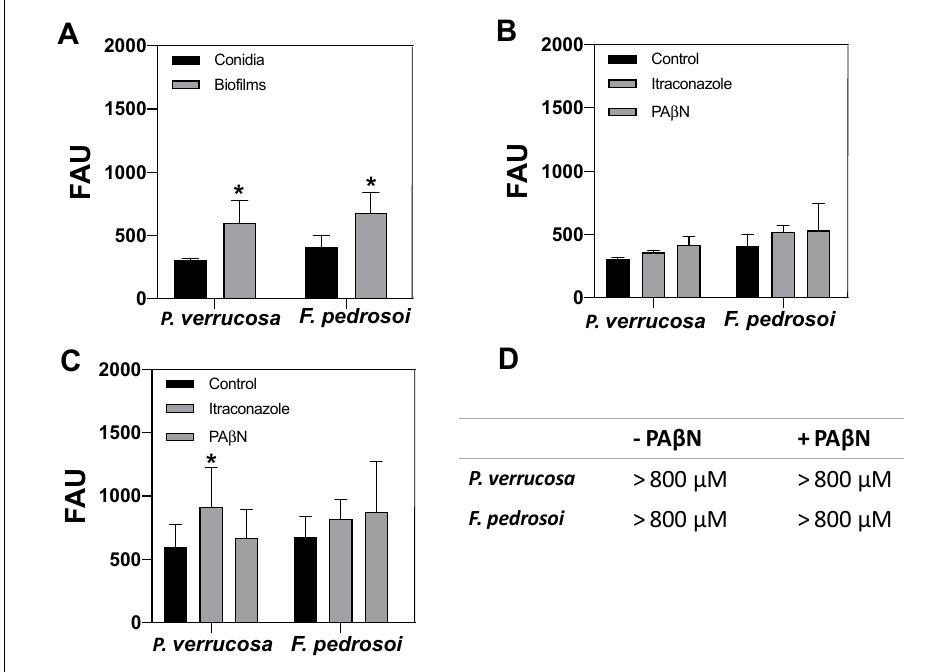
Figure 8. Activity of efflux pumps on conidia and biofilm-forming cells of F. pedrosoi and P. verrucosa . ( A ) Conidial cells and 72 h-old-biofilm (1 × 10 7 /mL, initial inoculums) were first incubated with rhodamine 6G (R6G, 10 µM) and then with glucose 2% in order to evaluate the glucose-induced efflux of R6G. ( B ) Conidia and ( C ) mature biofilm pretreated for 1 h with MICs of itraconazole or with phenylalanine-arginine beta-naphthylamide (PA β N, 64 µg/mL), before the addition of R6G and glucose. ( D ) Susceptibility assay of biofilm-forming cells treated for 48 h with itraconazole in the absence or the presence of PA β N determined with CLSI [56]. Data were expressed as fluorescence arbitrary unit (FAU) after a fluorimeter reading (excitation, 529 nm; emission, 553 nm). Symbol (*) represents p values ≤ 0.05 compared with control. 4. Conclusions In the present work, both F. pedrosoi and P. verrucosa were able to produce networks of filamentous forms with entangled and interconnected cells on a polystyrene surface, as found in the classic microbial biofilm formed by other pathogenic filamentous fungi. These special features, including the ability to adhere, produce extracellular matrix and increase the antifungal drug resistance, corroborated the potential biofilm formation by these CBM fungi. The ABC efflux pump activity of P. verrucosa and F. pedrosoi biofilms was significantly higher than that of their conidia. Future studies are necessary to clarify the resistance mechanism of the biofilm formed by these fungi and show its impact on CBM chronicity, which may contribute to achieving more effective treatment of this debilitating infection. Author Contributions: T.P.M., A.L.S.S., L.F.K. conceived and designed the study. I.S.S., T.P.M., M.Q.G., E.P.P. performed the experiments. All authors analyzed the data. C.S.A., A.L.S.S. and L.F.K. contributed reagents, materials and/or analysis tools. I.S.S., T.P.M., A.L.S.S. and L.F.K. wrote and prepared table and figures. All authors revised the paper, contributed to the research and approved the final version of the manuscript. All authors have read and agreed to the published version of the manuscript. Funding: This research was funded by grants from the Brazilian agencies Conselho Nacional de Desenvolvimento Científico e Tecnológico (CNPq, 142547/2018-3), Fundação de Amparo à Pesquisa no Estado do Rio de Janeiro (FAPERJ), Coordenação de Aperfeiçoamento de Pessoal de Nível Superior (CAPES, financial code 001) and Fundação Oswaldo Cruz (FIOCRUZ). Institutional Review Board Statement: Not applicable